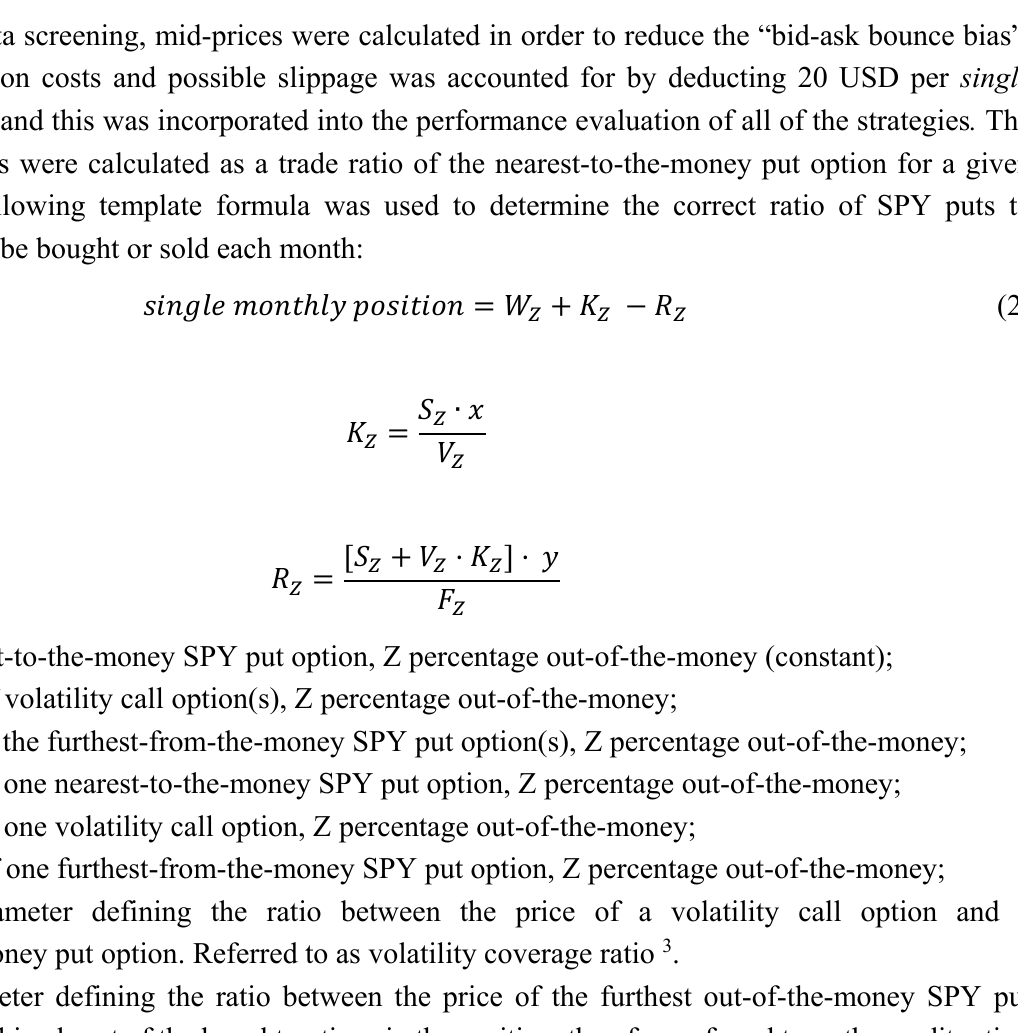
Figure 2. Trade staggering in a portfolio over a four-month